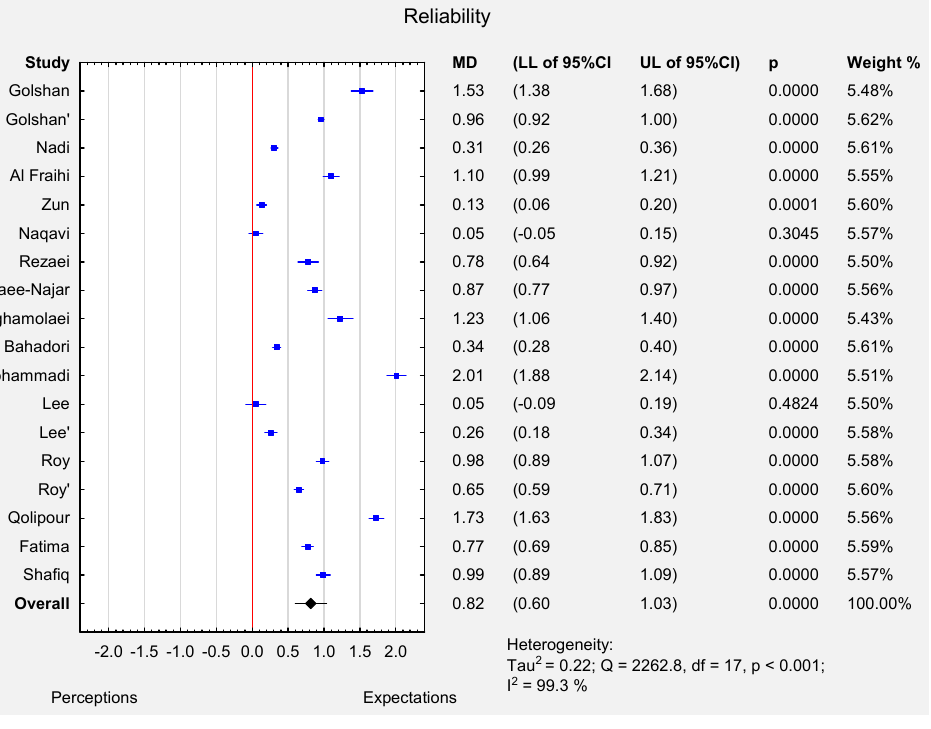
Figure 3. Forest plot for the mean difference ([MD]; 95% CI) of the patients’ perceptions and expectations in reliability dimension. According to a random effect meta-analysis (I-squared index 99.3%, p < 0.001), the